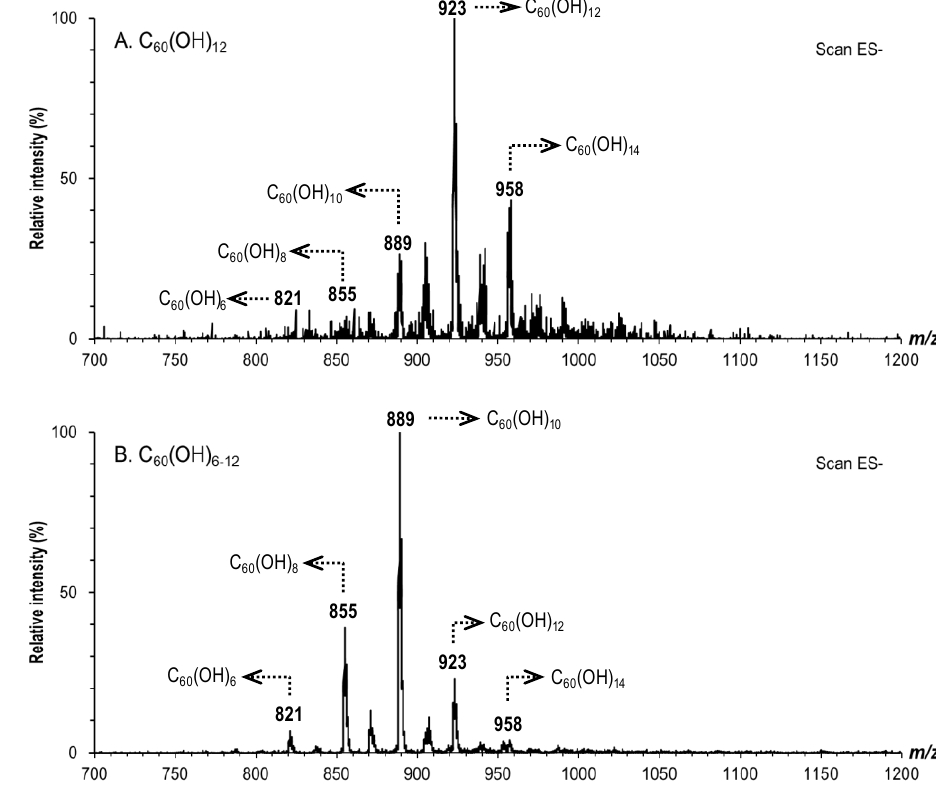
Figure 2. Mass Spectra of C